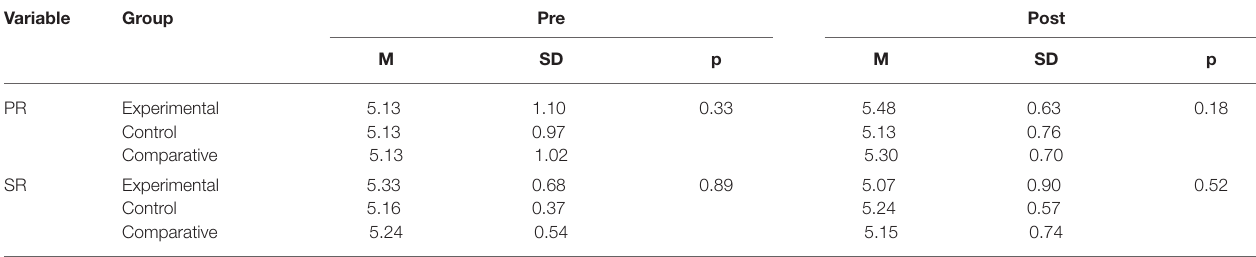
TABLE 8 | Intergroup and intragroup